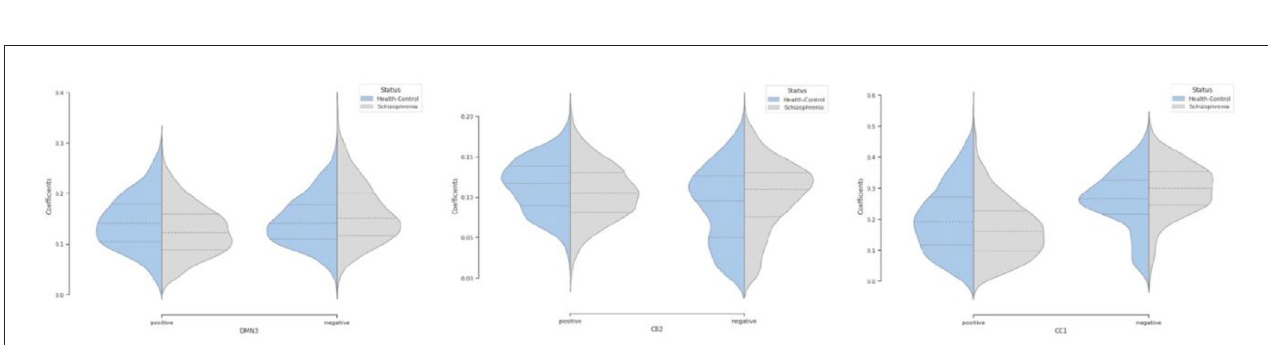
FIGURE5 Violin plot shows distribution of peak voxels in positive and negative segments for all subjects in default mode network (DMN3), cerebellar (CB2), cognitive control (CC1)